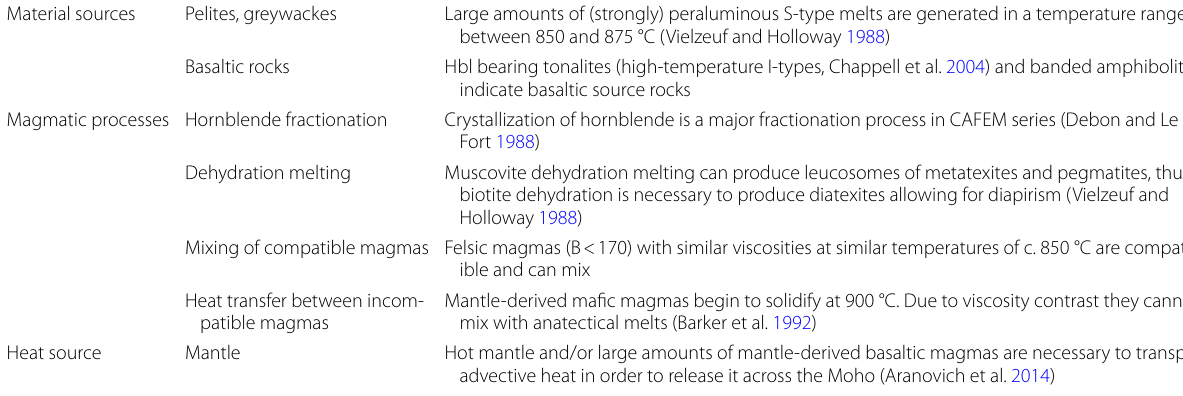
Table 3 Sources of material and heat, and processes of peraluminous arc magmatism in subduction–accretion complexes Material